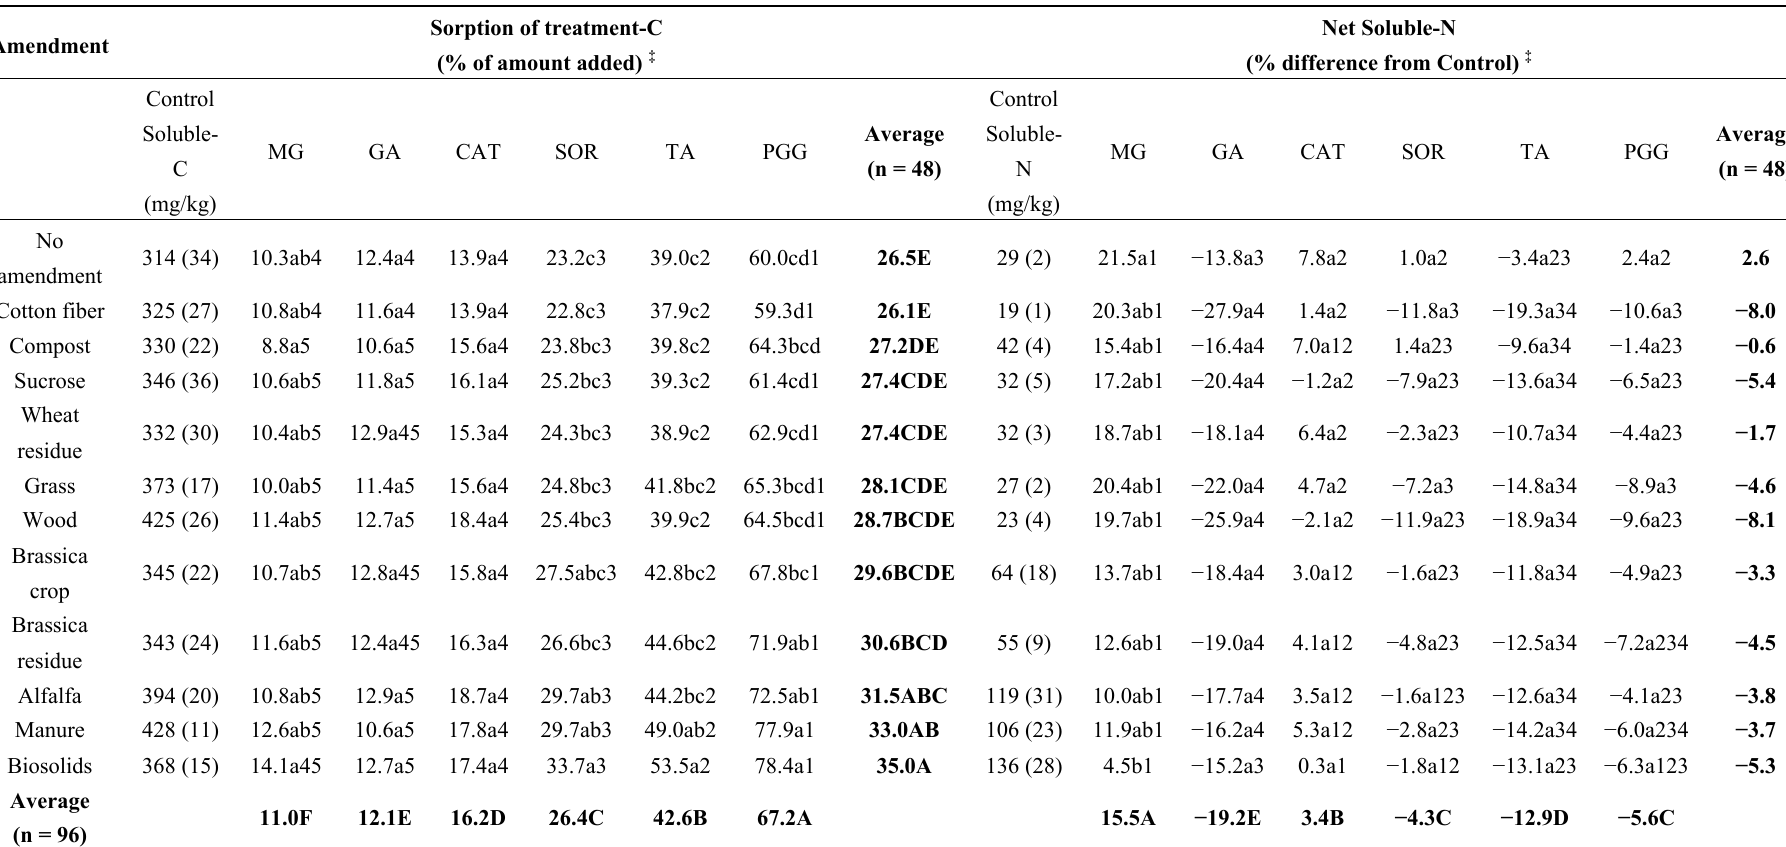
Table 3. Response of soils from the amendment field study at the Columbia Plateau Conservation Research Center , Pendleton, OR to addition of test compounds and a 1 hour shake at room temperature †